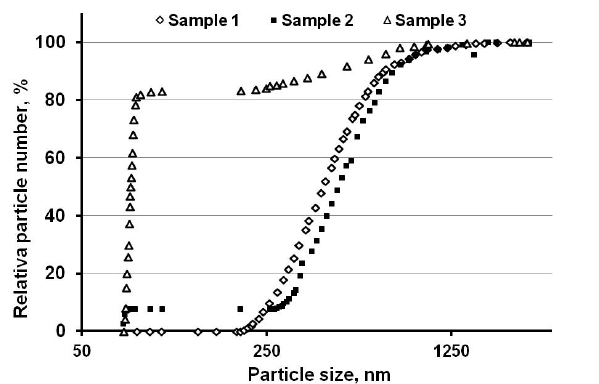
Figure 6. Integral particle size distribution of bimodal aluminum powders.